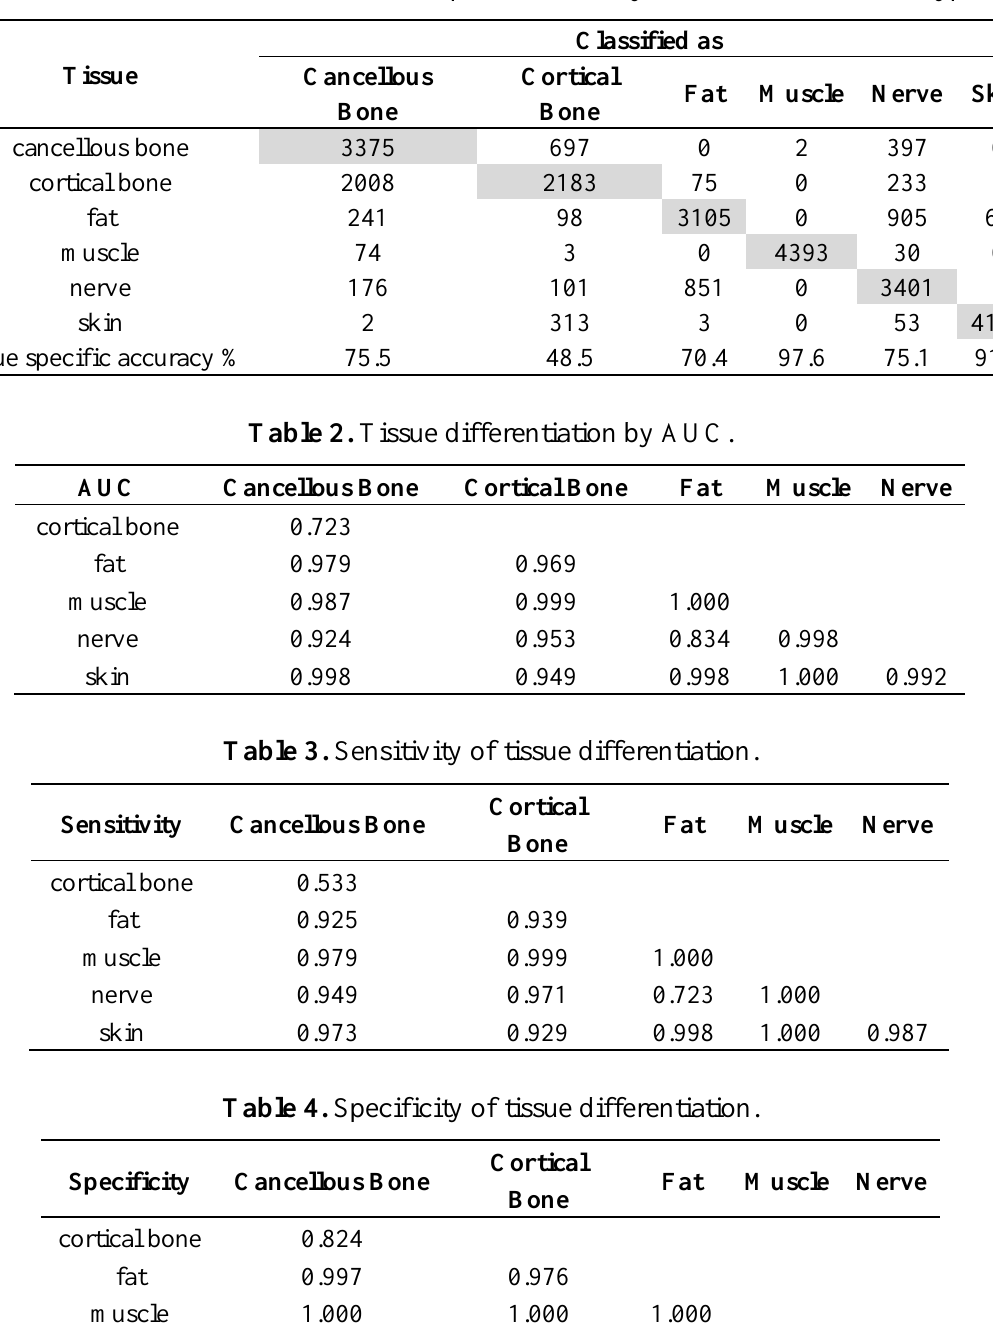
Table 1. Confusion matrix and tissue specific accuracy for the different tissue types.